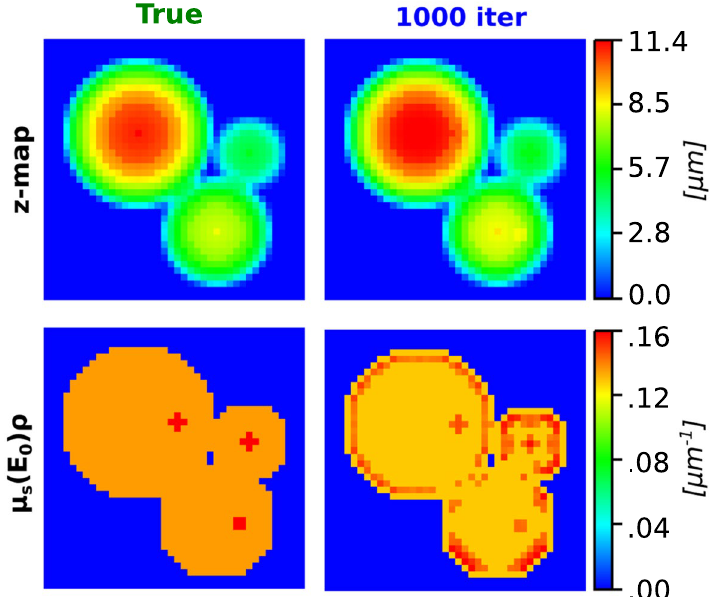
Figure 3. Comparison of z-map (top row) and µ s ( E 0 )ρ (bottom row), between the ground truth (left column) and data recovered from STXM after 1000 iterations (right